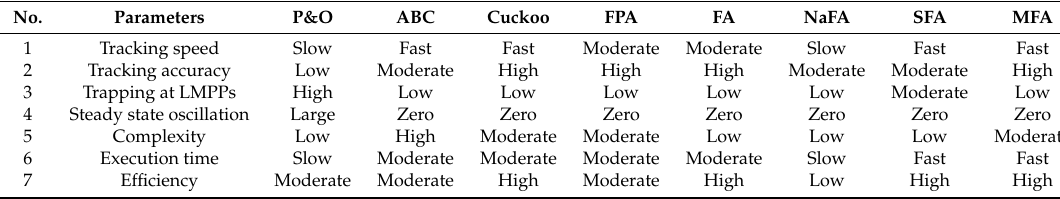
Table 16. Qualitative comparison of the proposed method with other algorithms.